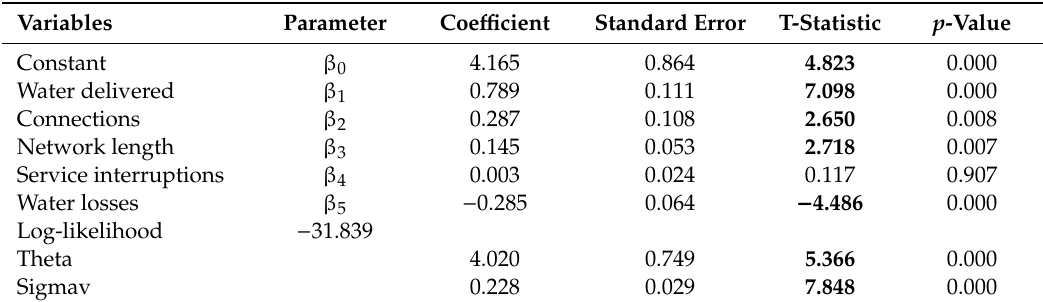
Table A1. Estimates of the cost frontier model for the original